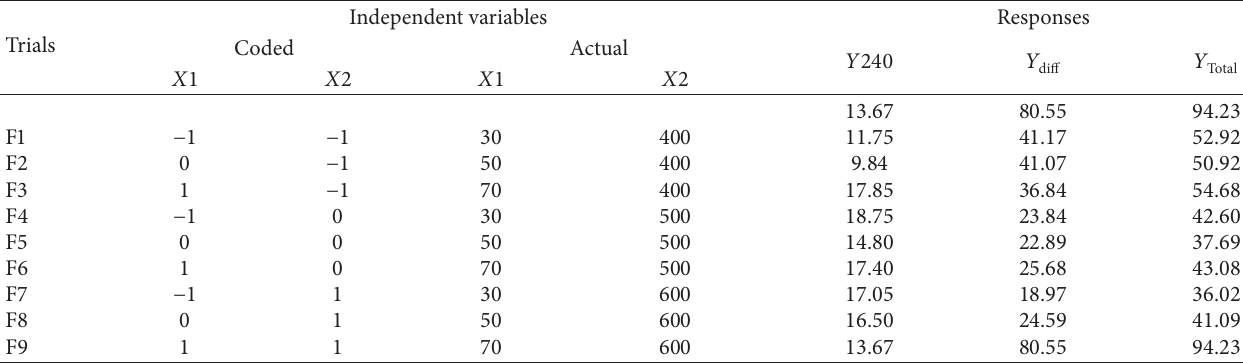
Table 1: 3 2 factorial batches with their